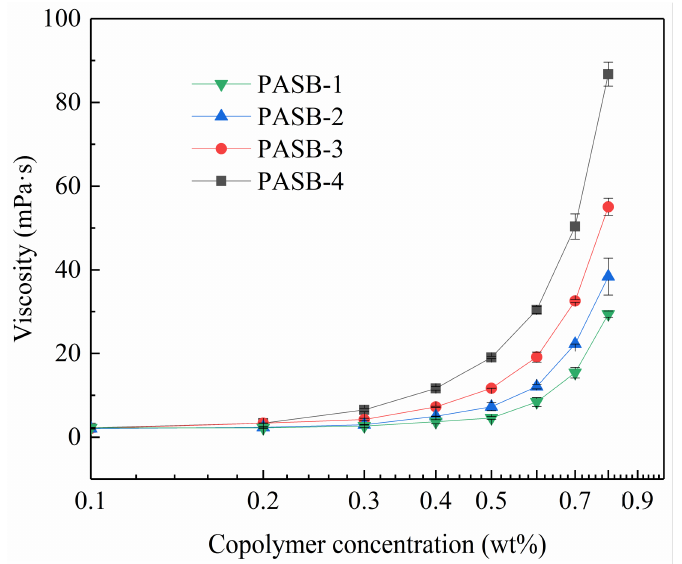
Figure 4. Viscosity of PASB copolymers as a function of copolymer concentrations at 56 ◦